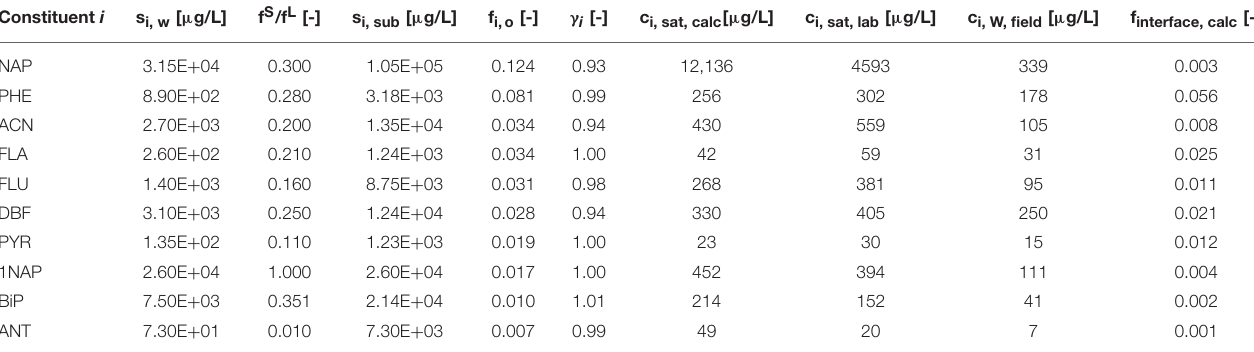
TABLE 1 | Aqueous equilibrium concentrations of some abundant coal tar constitutents, based on Raoul’ts law using aqueous solubilities s i, w (from Eberhardt and Grathwohl, 2002) and solid/liquid fugacity ratios at 25 ◦ C f S /f L (from Peters and Luthy, 1993) to calculate subcooled liquid solubilities (s i, sub ), activity coefficients γ i (adopted from Peters et al., 1999), molar DNAPL fractions f i, o , Raoult’s law (c i, sat, calc ), measured c i, sat, lab aqueous equilibrium concentrations, groundwater data (c i, w ) and theoretical molar fractions of a DNAPL/groundwater interface (f interface, calc